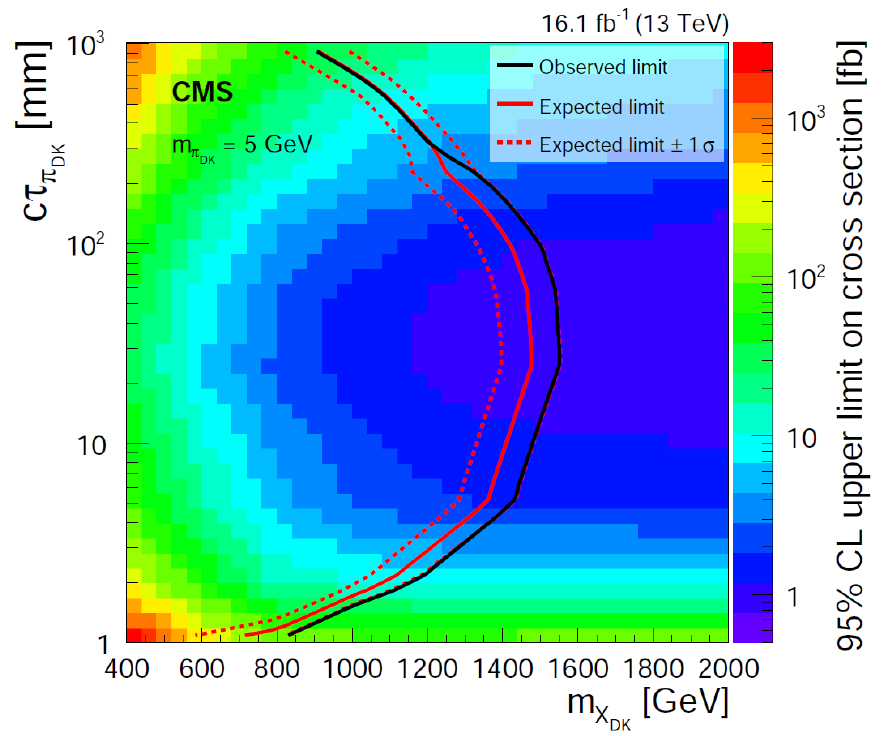
Figure 10 . Upper limits at 95% CL on the signal cross section and signal exclusion contours derived from theoretical cross sections for models with dark pion mass m (cid:25) plane. The solid red contour is the expected upper limit, with its one standard-deviation region enclosed in red dashed lines. The solid black contour is the observed upper limit. The region to the left of the observed contour is